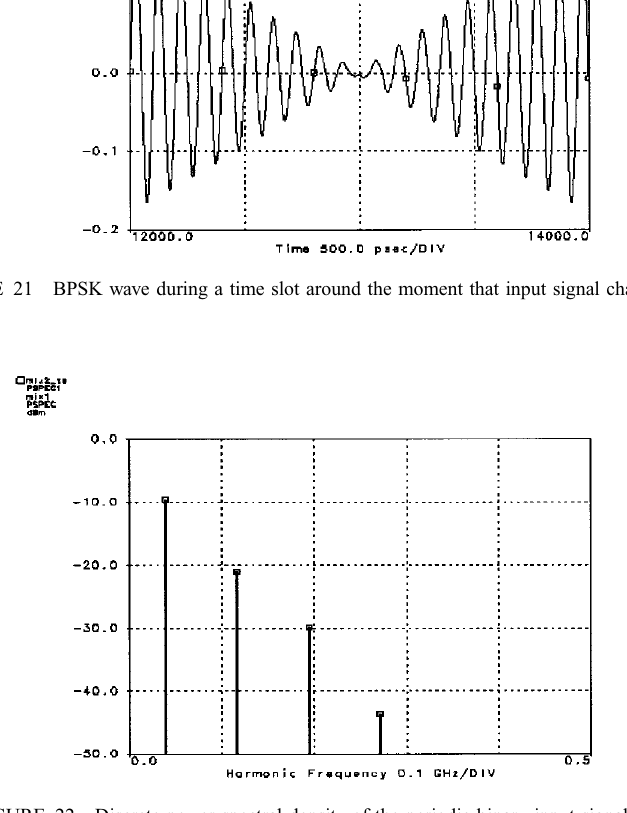
FIGURE 22 Discrete power spectral density of the periodic binary input